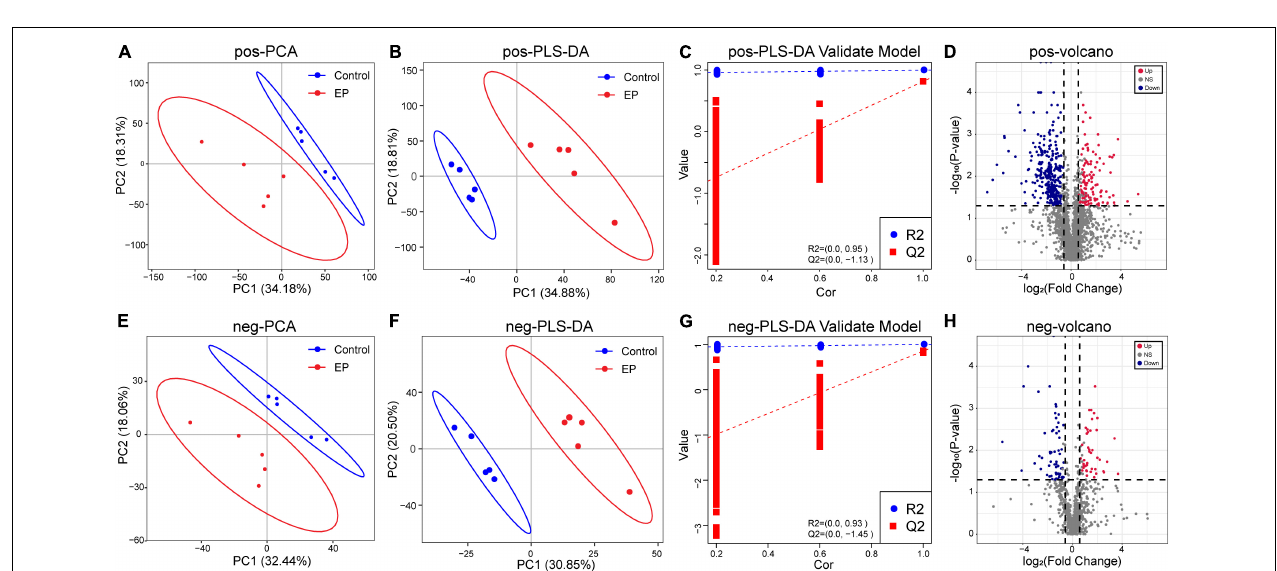
FIGURE 4 | Differences of metabolic profiles between EP and Control groups based on LC–MS technology. Principal component analysis (PCA) analysis of positive ions (A) and negative ions (E) . Partial least-squares method–discriminant analysis (PLS–DA) analysis of positive ions (B) and negative ions (F) . The response permutation testing of PLS–DA for positive ions (C) and negative ions (G) . The volcano chart shows the difference in positive ion metabolites (D) and the difference in negative ion metabolites (H) between EP and Control groups. The red point means upregulation, blue point means downregulation. EP, experimental periodontitis group; Control, healthy control group; pos, positive ions; neg, negative